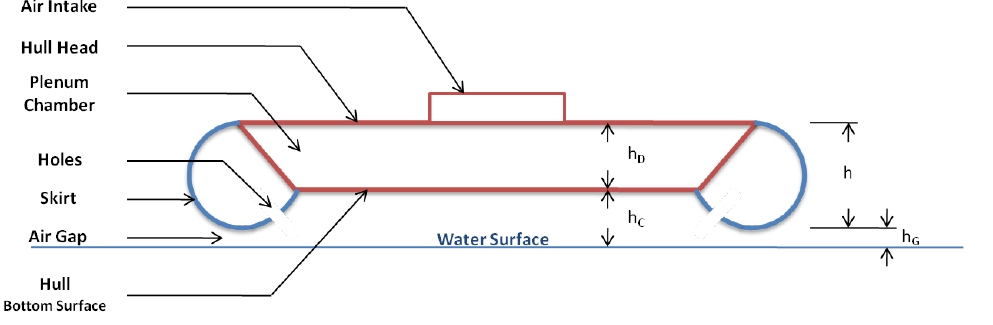
Figure 1. Schematic diagram of